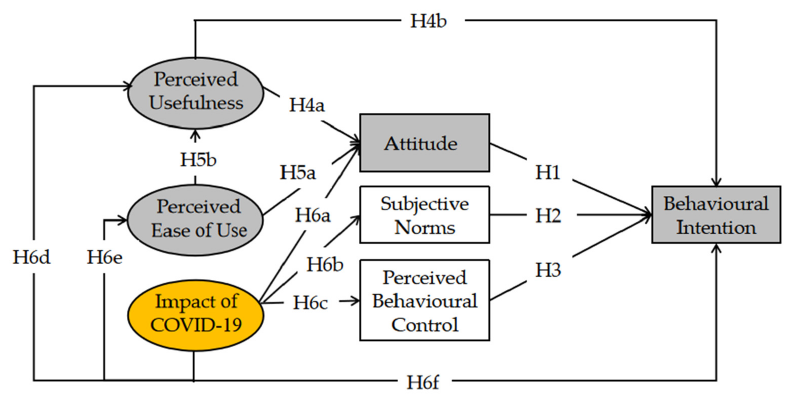
Figure 1. Research model. Note: The white and grey blocks are the constructs from the TPB framework; the grey blocks and grey ovals are the constructs in the TAM framework; and the yellow oval is a new pandemic variable added in the conceptual model.